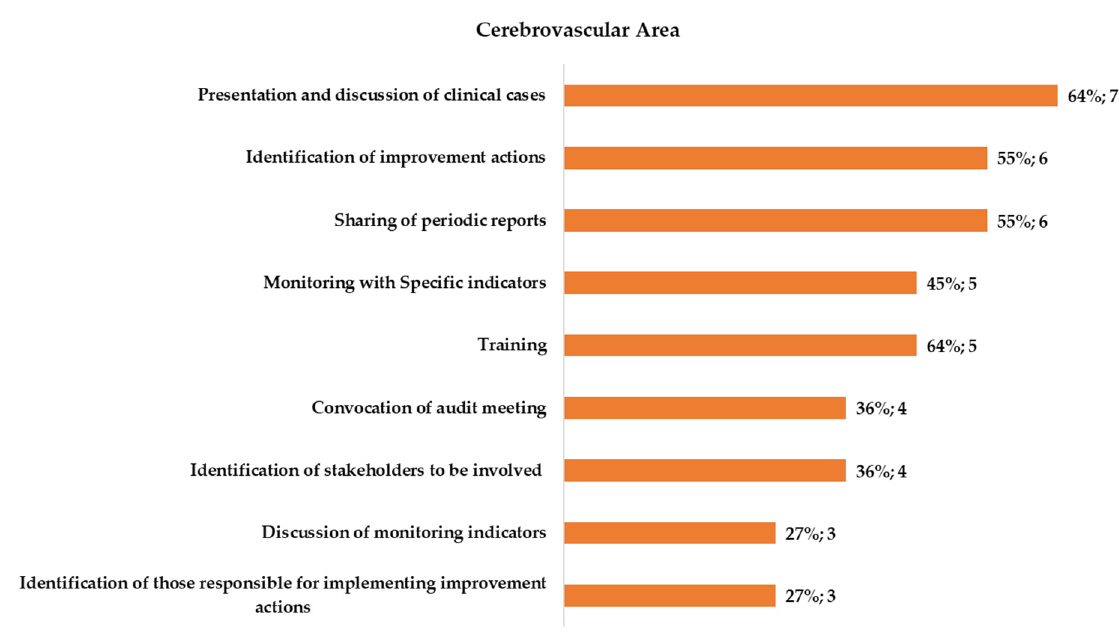
Figure 2. Type of assimilating A&F procedures reported by the respondents for the cerebrovascular